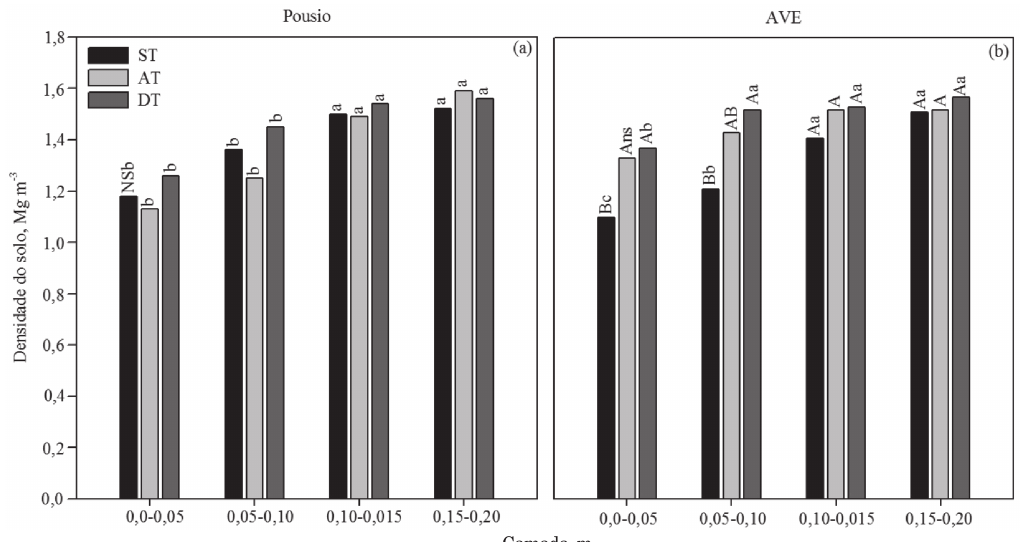
Camada, m Figura 1. Densidade do solo nos sistemas de manejo pousio (a) e aveia + ervilhaca (b), nas condições de sem tráfego (ST), antes do tráfego (AT) e depois do tráfego (DT), em camadas. Letras iguais não diferem significativamente pelo teste de Tukey (p<0,05). Letras maiúsculas comparam condições de tráfego em cada camada e minúsculas, camadas em cada condição de tráfego.